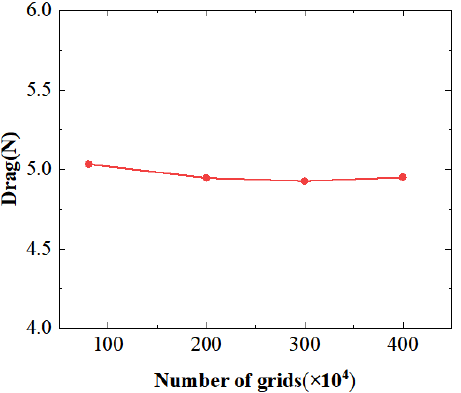
Figure 5. Mesh independence of the AUG in terms of drag.